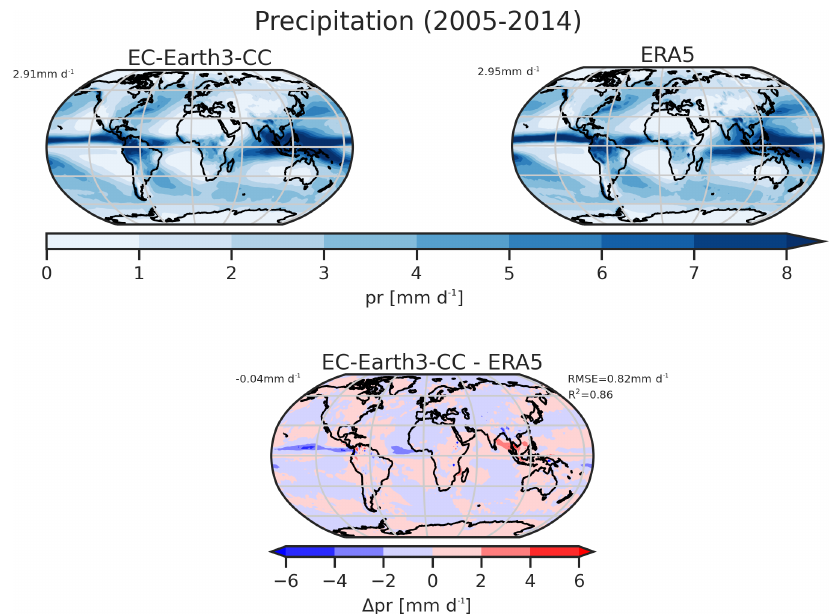
Figure 6. Global precipitation climatology from EC-Earth3-CC including the bias relative compared to ERA5 averaged over 2005 to 2014. Numbers in the top left corner correspond to the (area-weighted) global average of the fields. Numbers in the top right corner of the bias plots correspond to the (area-weighted) root-mean-square error (RMSE) and the (area-weighted) coefficient of determination ( R 2 ) of the EC-Earth3-CC and ERA5 fields. The simulation shown here is an AMIP simulation that has been published as part of the CMIP6 ensemble (ensemble member r1i1p1f1 ).